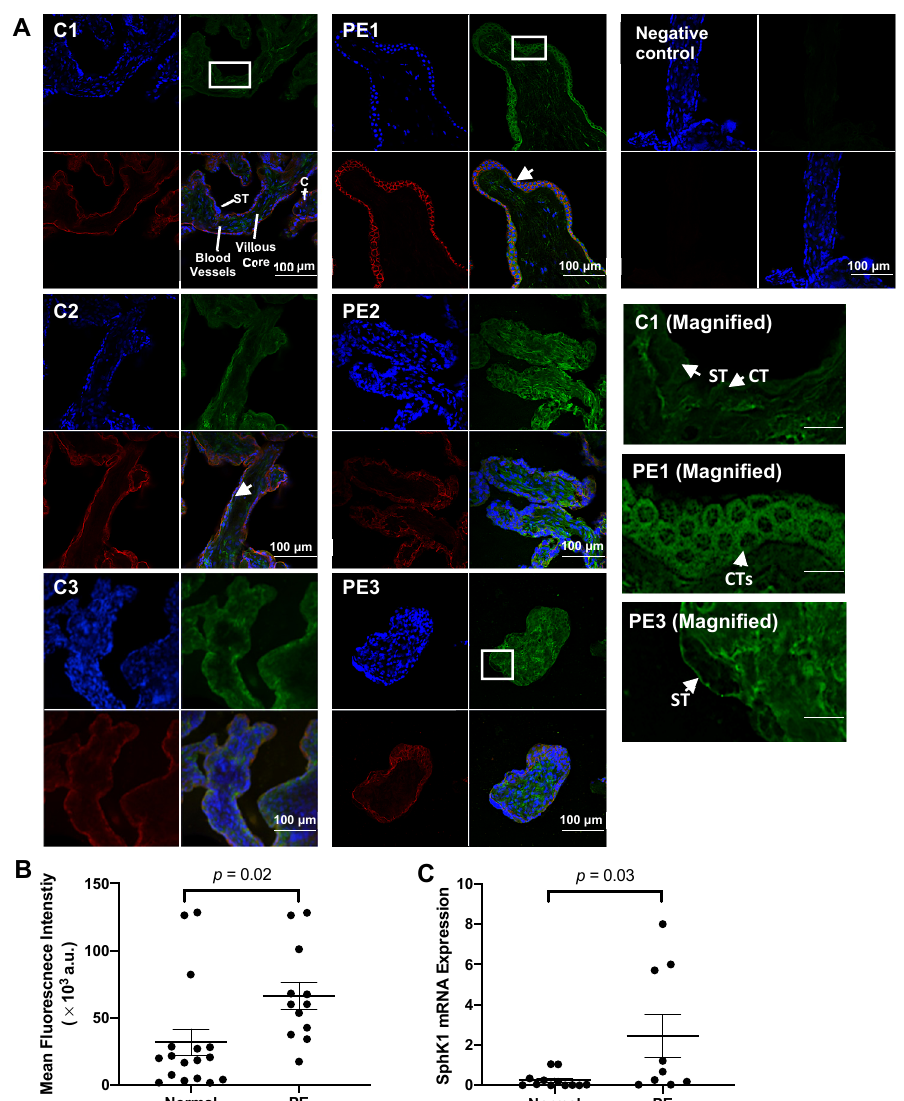
Figure 1. Sphingosine kinase 1 (SphK1) expression was higher in placental biopsies from women with preeclampsia (PE). ( A ): SphK1 was expressed throughout the villi, the cytotrophoblast (CT), and the syncytium (ST). Images correspond to three representative samples from healthy control pregnancies (C1, C2, C3 images) and PE (PE1, PE2, PE3 images). Whole tissue placental biopsies from women with normal or PE pregnancies were co-stained for SphK1 (AF488, green) and E-cadherin (AF594, red) expression and a nuclear stain (DAPI, blue) and visualized by confocal microscopy. For the negative control, both AF488 and AF594 secondary antibodies were used in the absence of primary antibodies. White arrows show examples of overlap between E-cadherin and SphK1 ( B ): Whole sample image analysis normalized to total nuclear count showed higher SphK1 fluorescence in placental biopsies from women with PE compared to healthy control pregnancies. Student’s t -test ( n = 17 normal, n = 12 PE, Mean ± SEM). ( C ): Fold change in SphK1 mRNA expression in placental biopsies from women with PE relative to healthy control pregnancies using the ΔΔ Ct method. Student’s t -test ( n = 13 normal, n = 9 PE, Mean ± SEM).